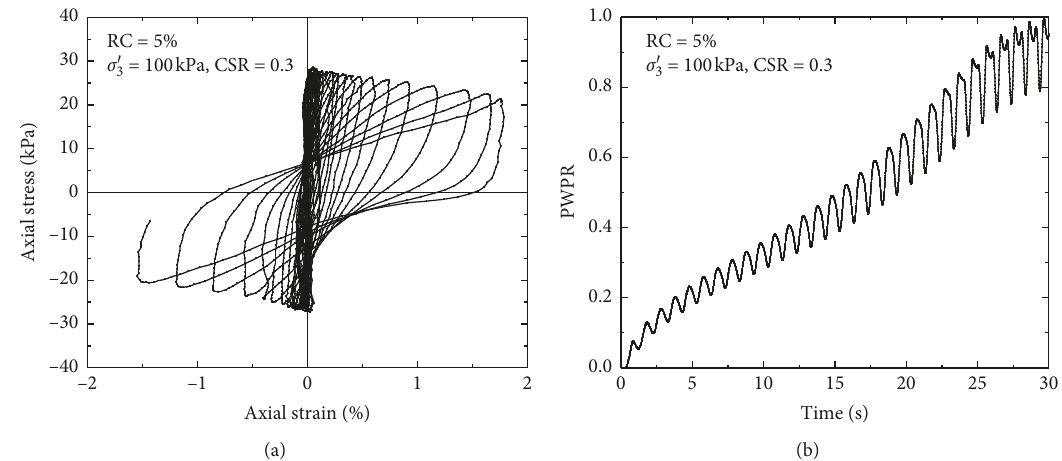
Figure 9: Typical experimental results for RC � 5%, σ histories of PWPR.